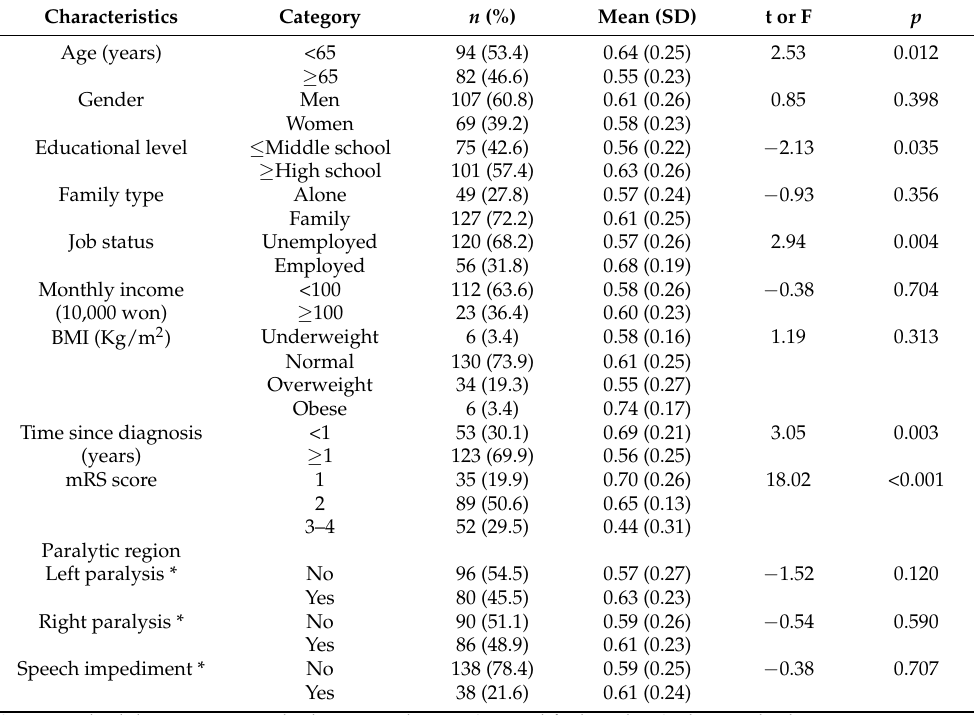
Table 1. Patients’ sociodemographic and clinical characteristics and differences in health-related quality of life ( n =